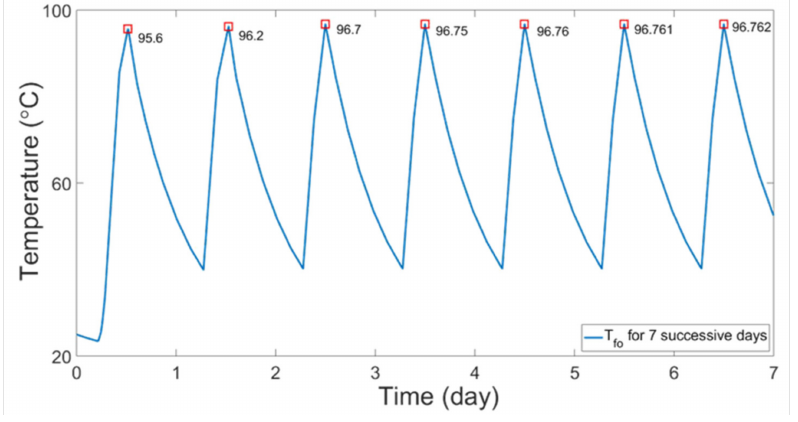
Figure 4. The solar collector outlet temperature for 7 successive